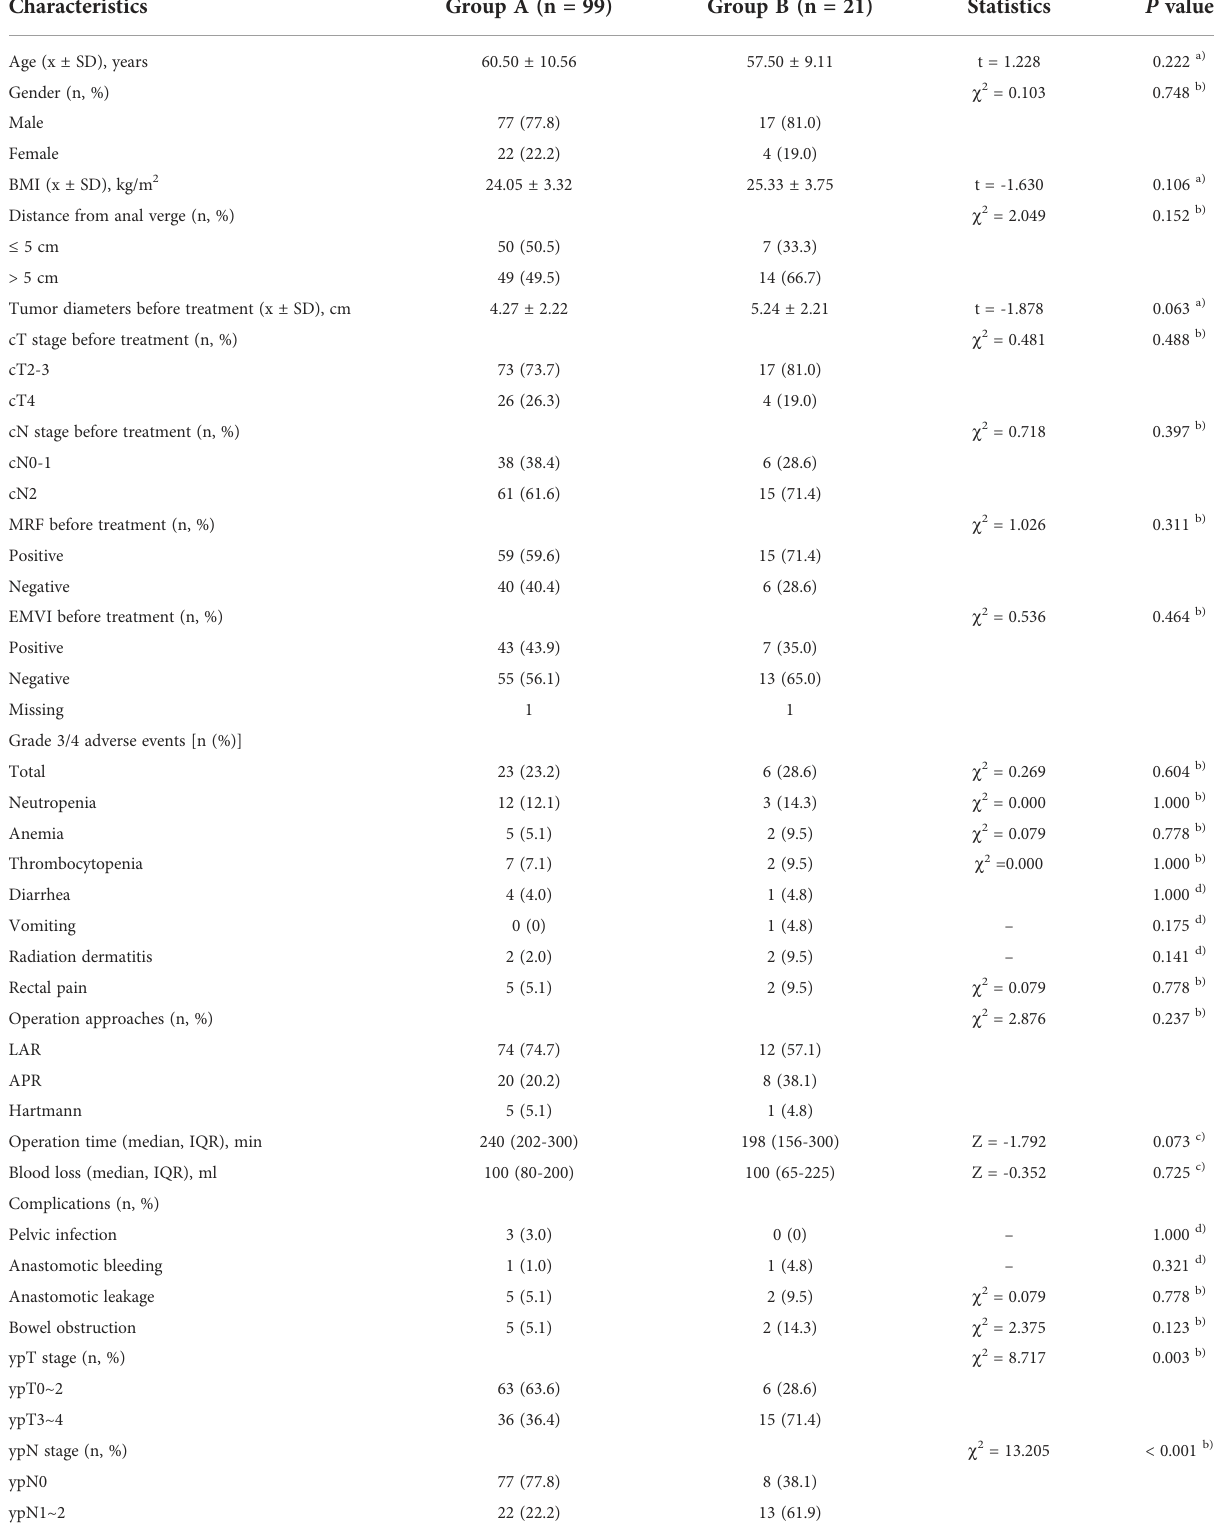
TABLE 3 Comparison of clinical and pathological characteristics of patients with locally advanced rectal cancer following total neoadjuvant therapy strati fi ed by the clearance in the carcinoembryonic antigen level after